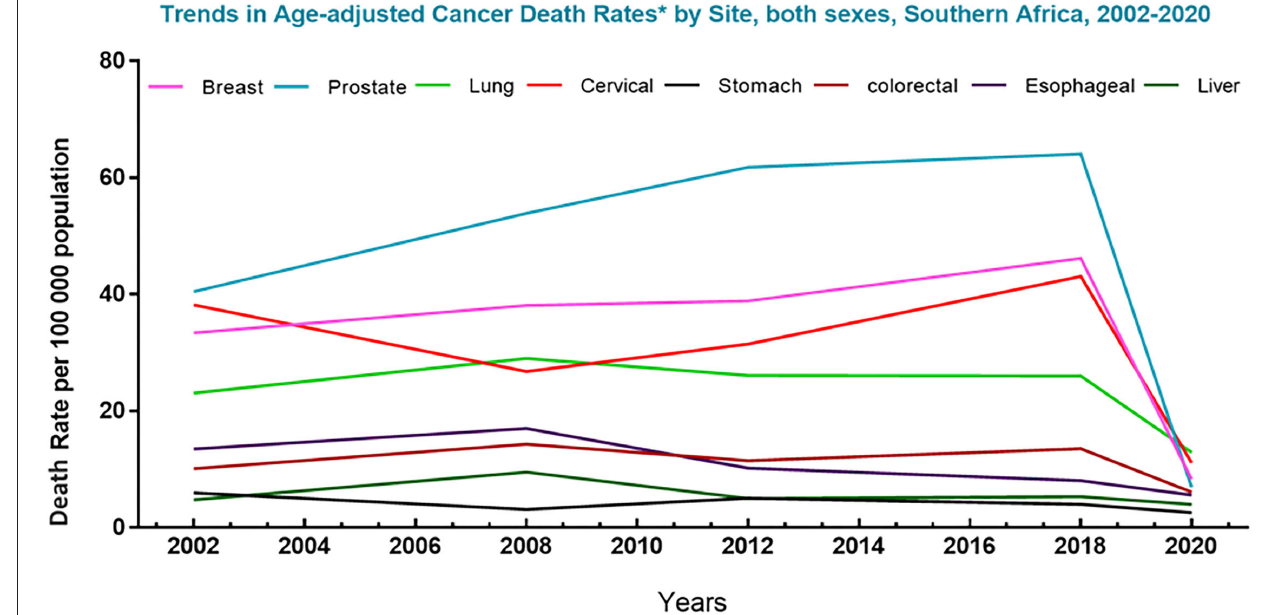
FIGURE 2 | Trends in cancer mortality in Southern Africa (2002–2020). Graph represents deaths associated with the top 8 cancers in South Africa for men and women, per 100,000 population, over the last decades. The data shows a sharp decline in the death rate of the top eight cancers in this region. Data source: Globocan 2021; Hamdi et al. ( 13).